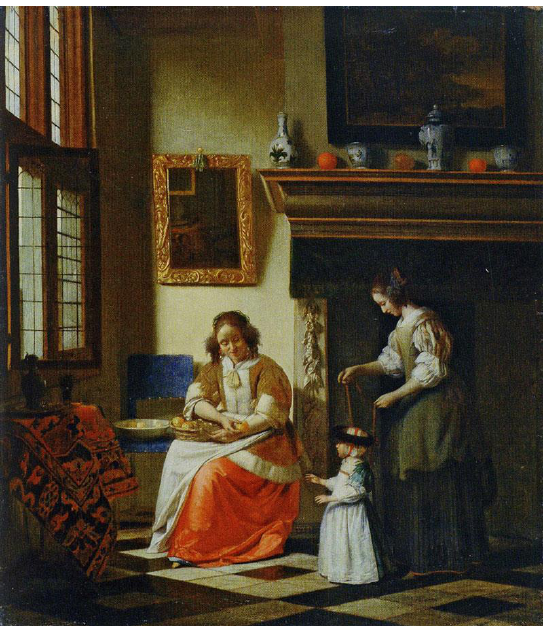
Figure 4. Pieter de Hooch, Teaching a Child to Walk , 1668 – 1672, oil on canvas, 28.9 × 25.9 in (73.5 × 66 cm), Museum der bildenden Künste, Leipzig.